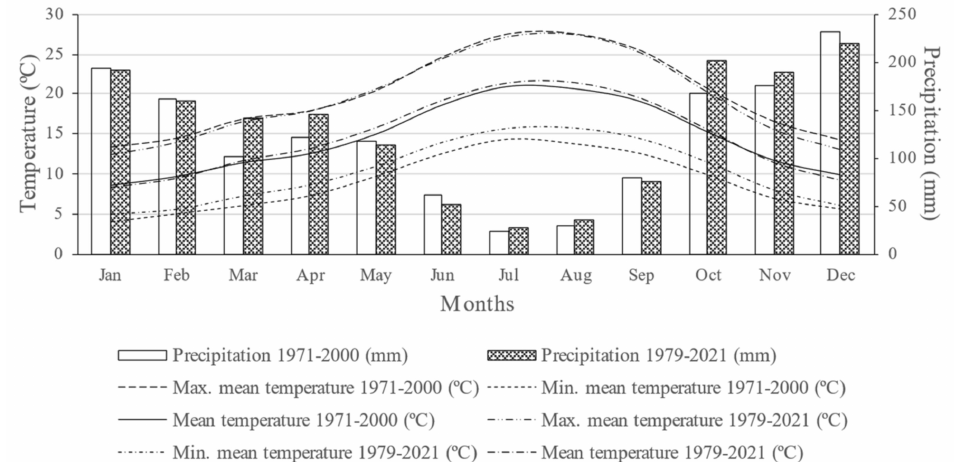
Figure 8. Overlaying the climatic data collected in the period of 1979–2021 with the climatic normal, corresponding to the period